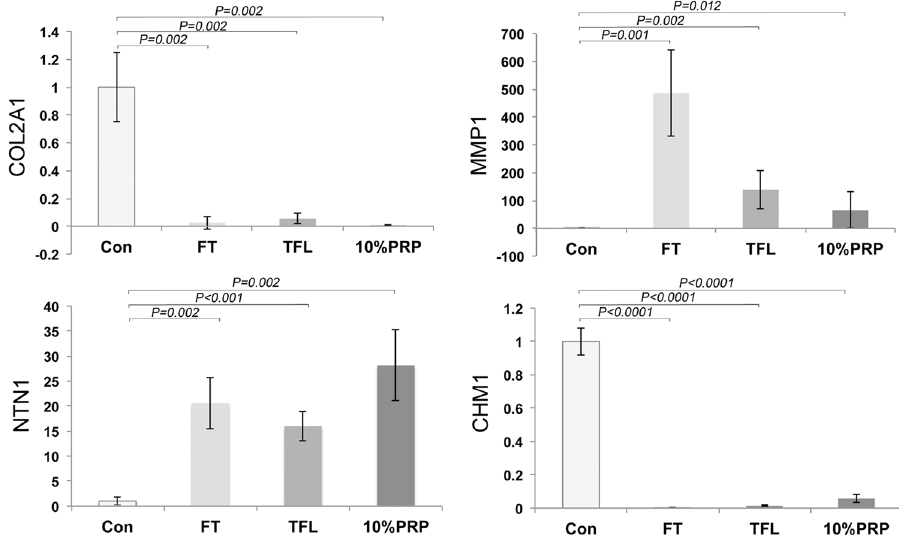
Figure 6. Growth factor concentrations of TGF β 1 and FGF2 comparable to those in PRP elicit similar gene expression profiles in cultured explants. Explants were cultured in medium containing 100 ng ml − 1 FGF2 and 10 ng ml − 1 TGF β 1 (FT), 10 ng ml − 1 TGF β 1 and 17.5 pg ml − 1 FGF2 (TFL), or, 10% PRP. The y-axis shows the relative fold change in gene expression calibrated to control